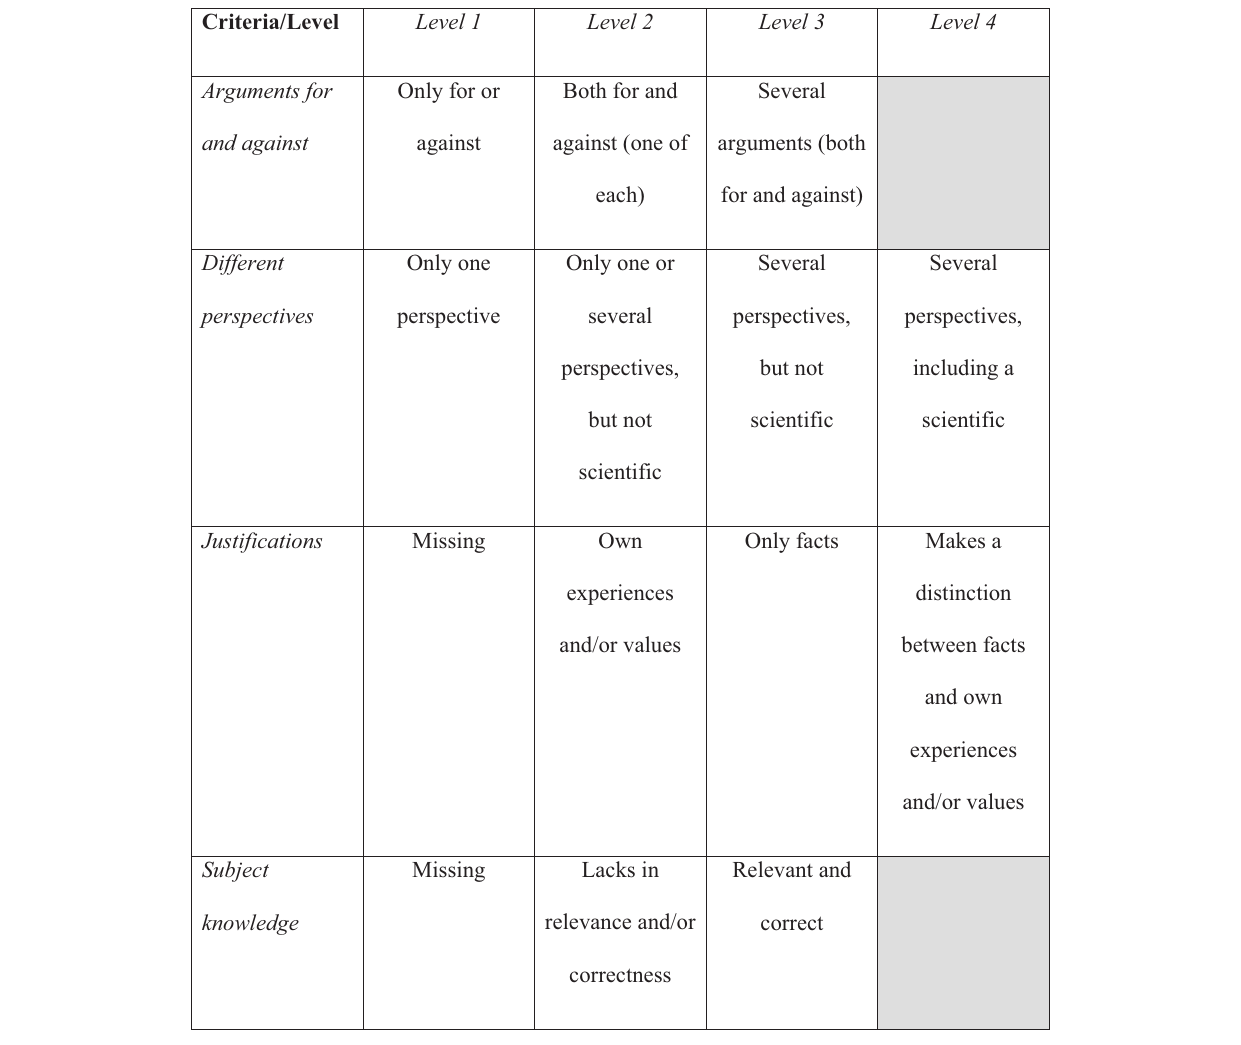
FIGURE 2 | Example of criteria used for assessment, feedback, and for sharing with students. The criteria in the figure refer to student argumentation in socio-scientific